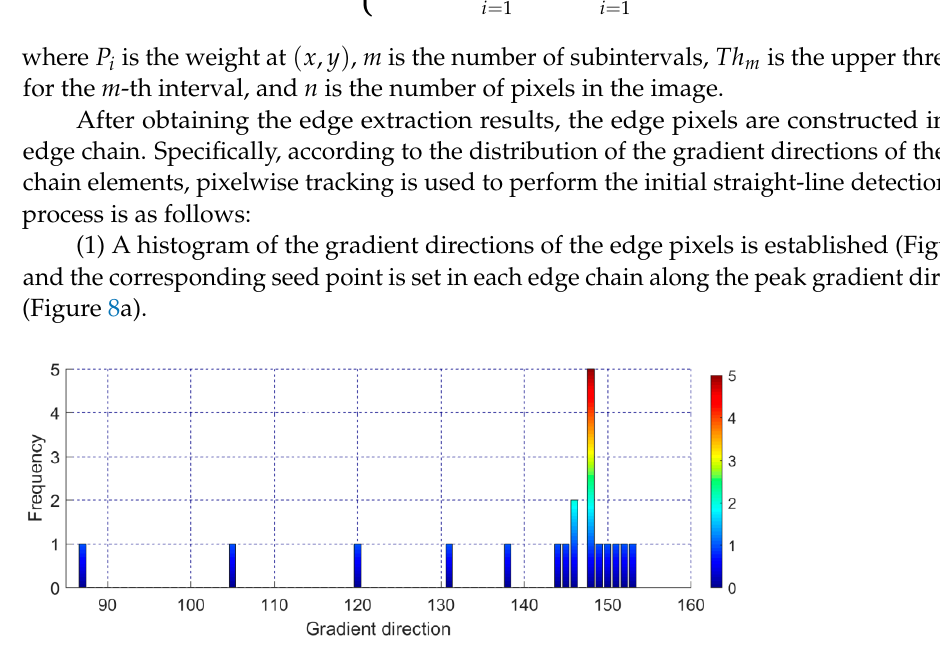
Figure 7. The histogram of the gradient directions. The horizontal axis means the direction of the gradient (Unit: degree ), and the vertical axis represents the number of occurrences.